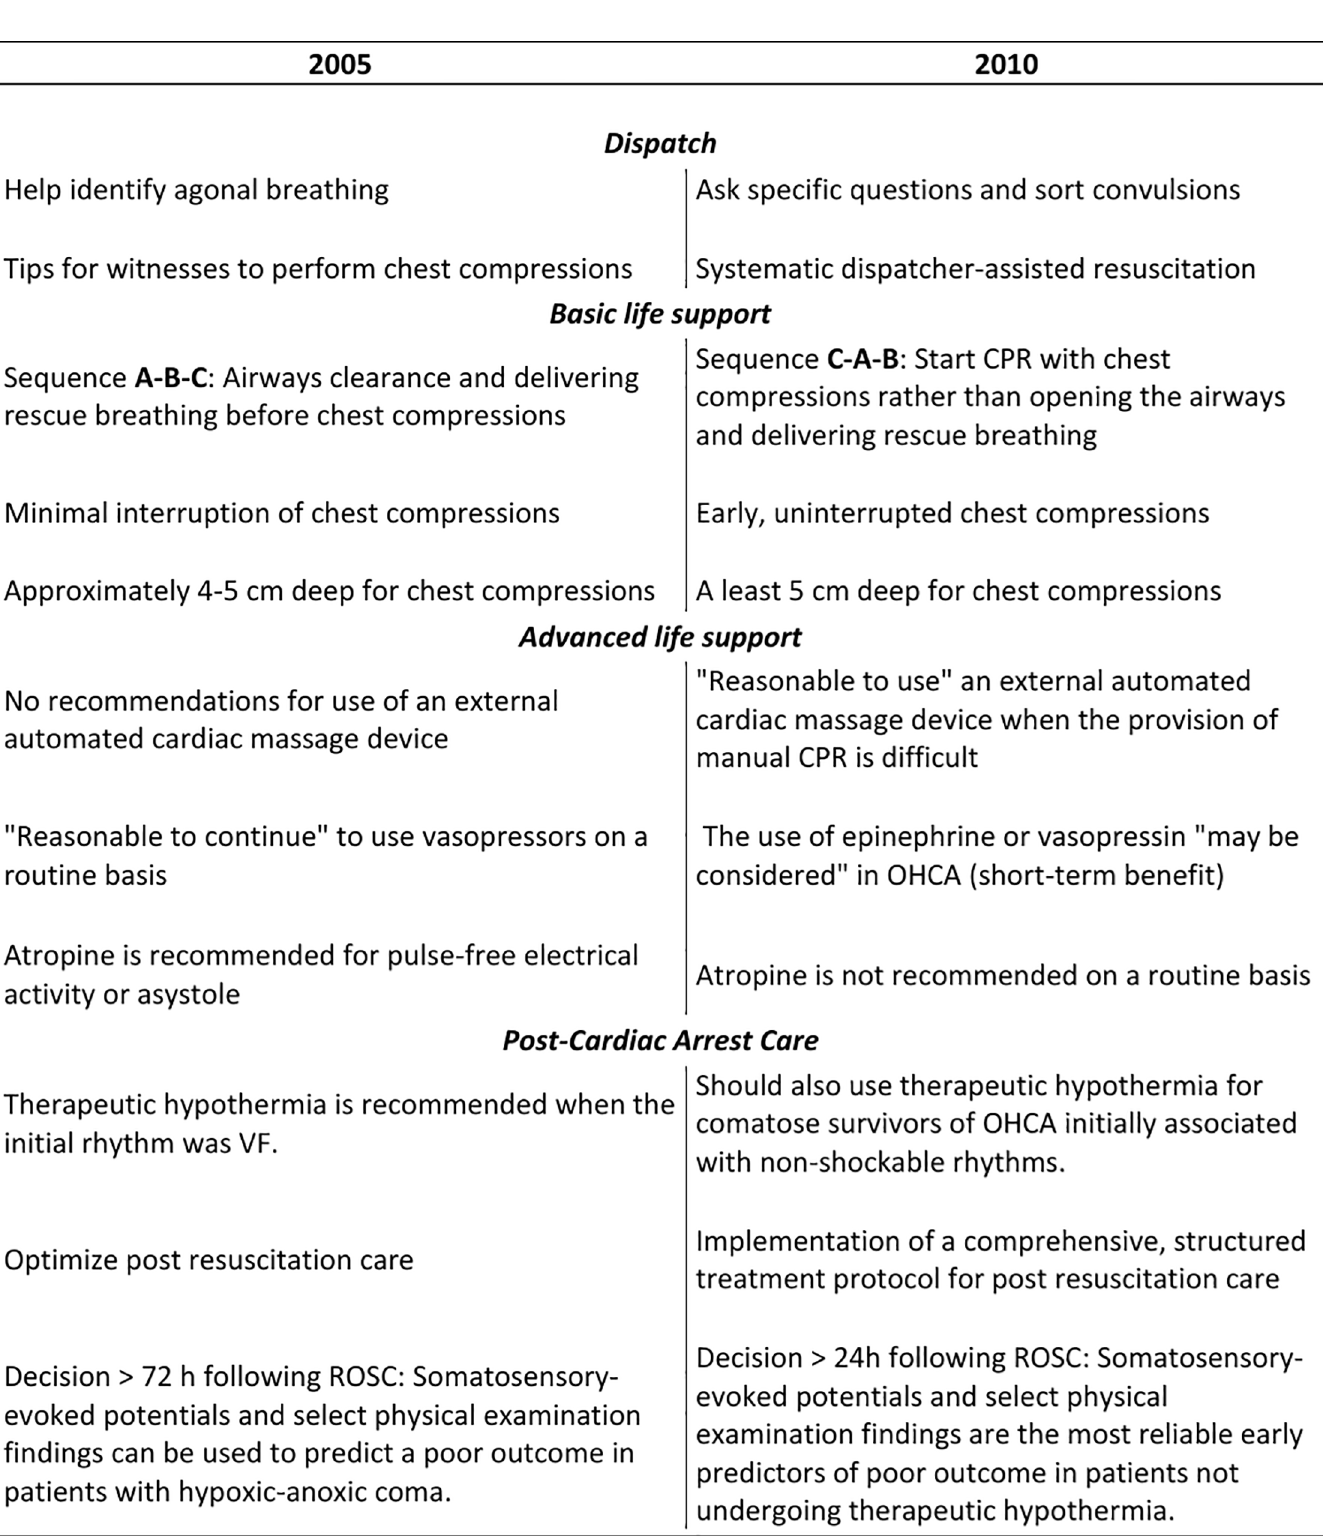
Fig 1. Major changes between 2005 and 2010 resuscitation guidelines. https://doi.org/10.1371/journal.pone.0204169.g001 PLOS ONE | https://doi.org/10.1371/journal.pone.0204169 September 24,